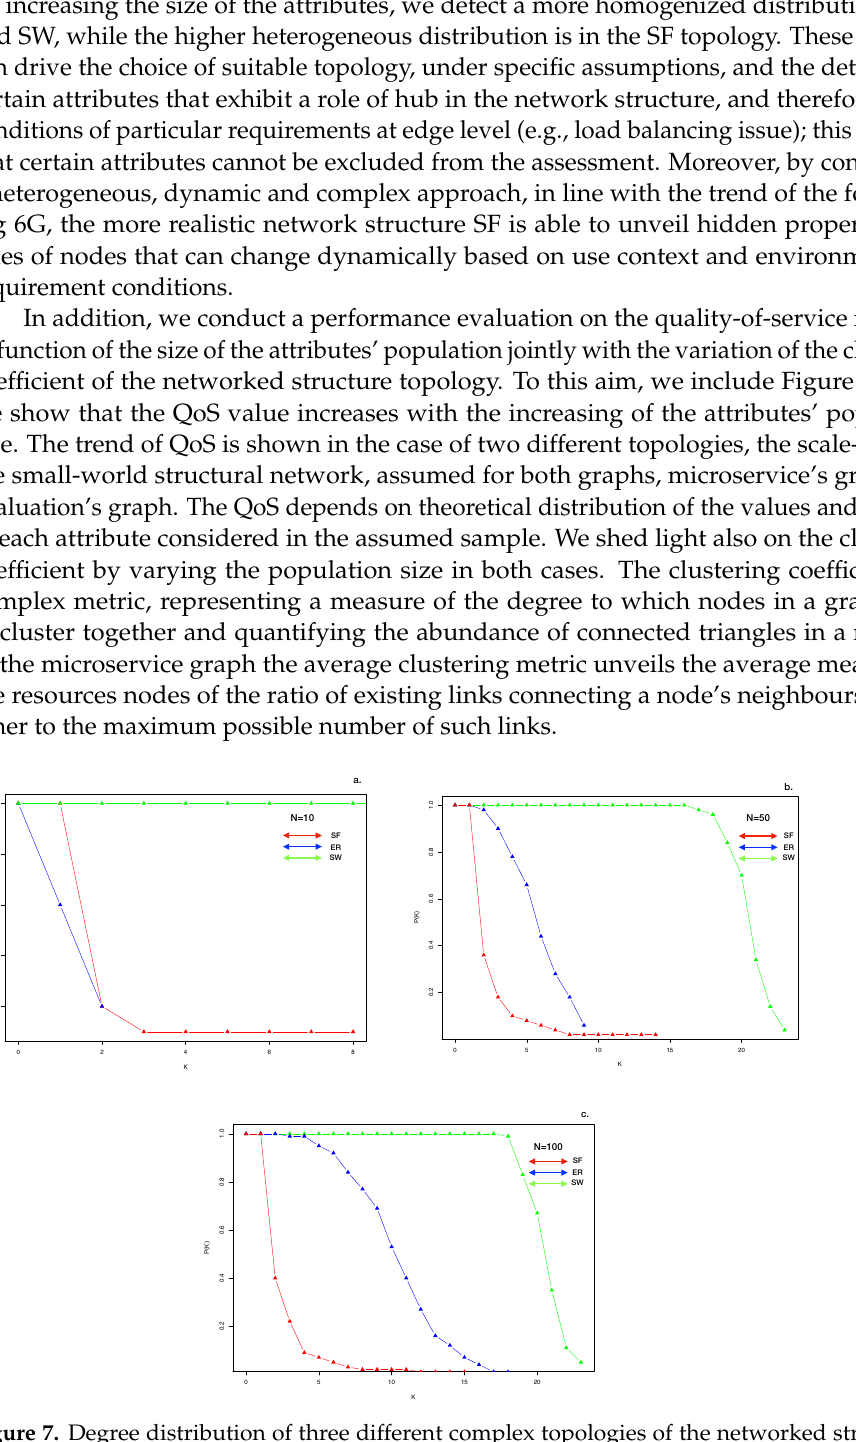
Figure 7. Degree distribution of three different complex topologies of the networked structure of attributes. The figure show the degree distribution P ( K ) in function of the degree k . In ( a ) we consider a population size N = 10, in ( b ) N = 50, in ( c ) N = 100. In the three plots we shed lights on three different topologies: Scale-Free network (SF) (red line), Erd˝os–Rényi networks (ER) (blue line), Small-World networks (SW) (green